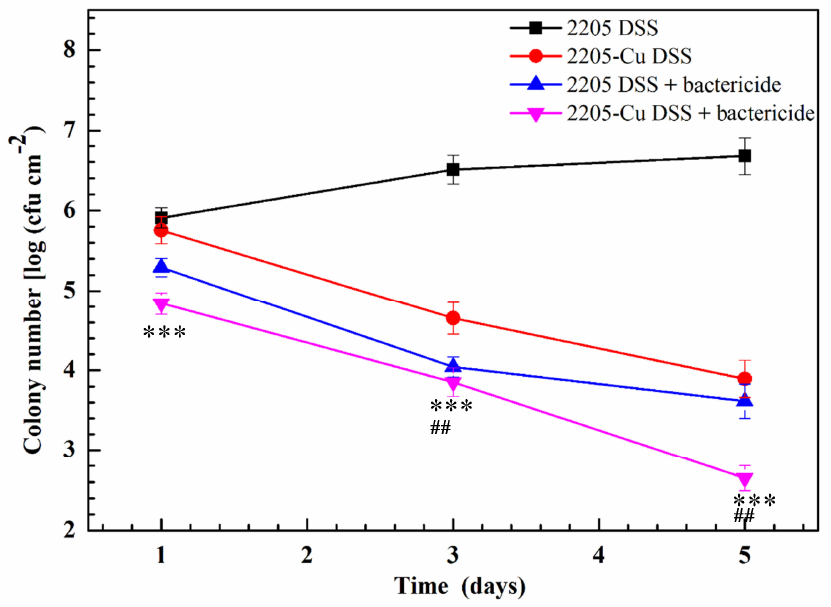
Figure 2. Colony numbers of the biofilms on 2205 DSS and 2205-Cu DSS after the 1-, 3-, and 5-day incubations. The bactericide is benzalkonium bromide. *** p < 0. 001 (sample vs. the 2205 DSS group); ## p < 0.01 (sample vs. the 2205-Cu DSS group). ( n = 3).